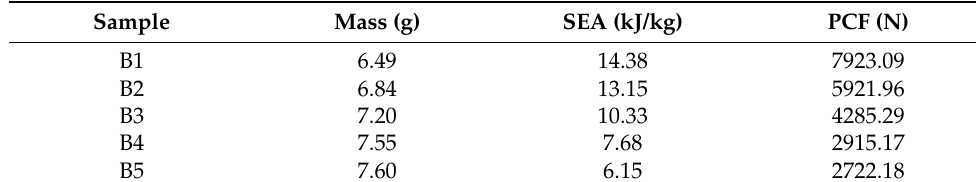
Table 3. Numerical results of specimens with different sizes of h .